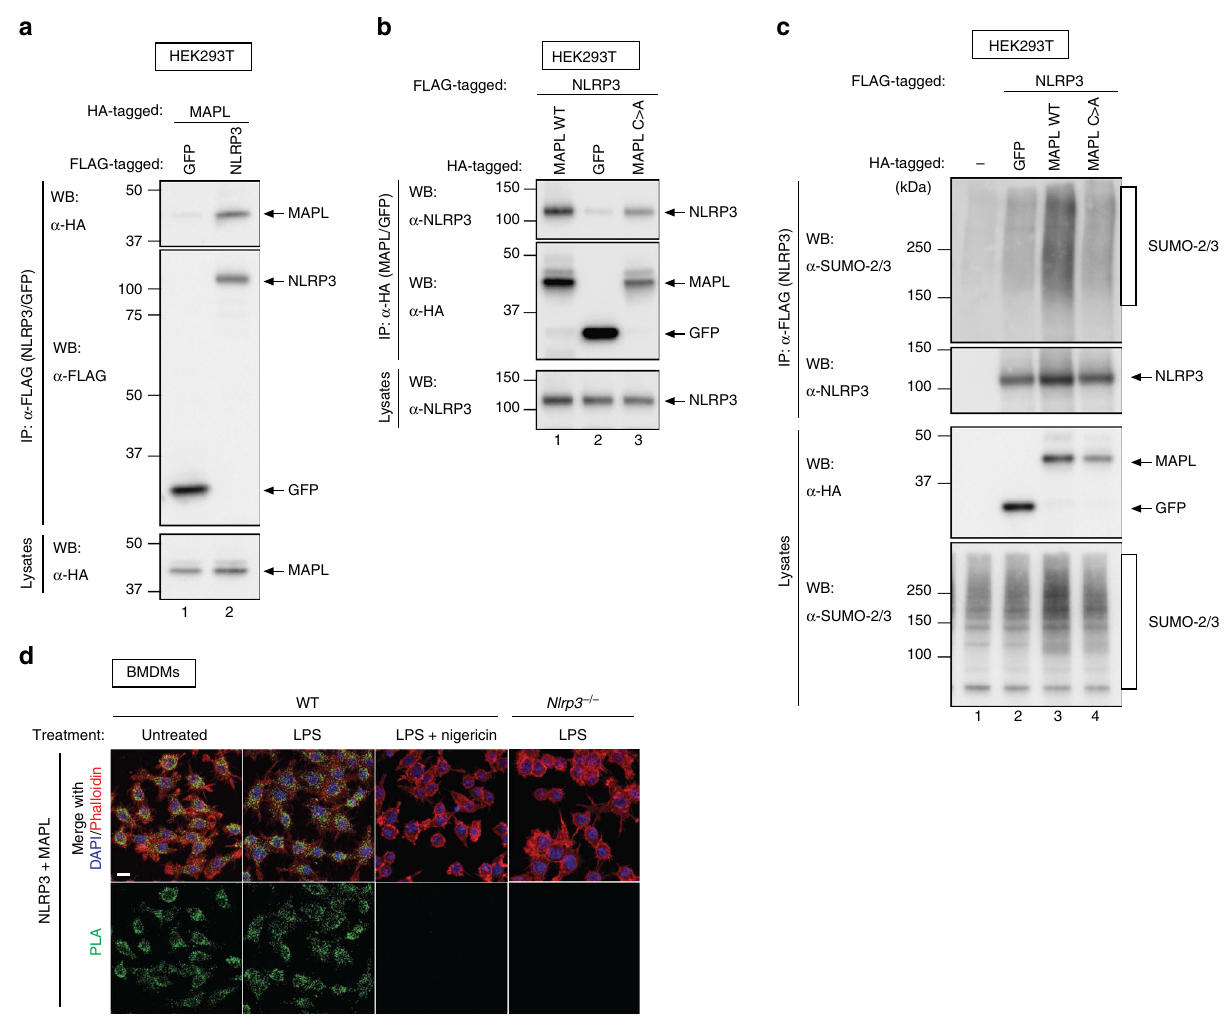
Fig. 3 SUMO E3 ligase MAPL interacts and sumoylates NLRP3. a , b Reciprocal binding study with NLRP3 and MAPL in HEK293T. Expression and co- precipitation was determined by western blot with the indicated antibodies. c Sumoylation of FLAG-NLRP3 in the presence of the indicated proteins. FLAG- NLRP3 was puri fi ed under denaturing conditions and the presence of SUMO modi fi cation on NLRP3 was determined by immunoblot analysis of the eluate. Representative immunoblots of three independent experiments are shown. d The endogenous proximity between NLRP3 and MAPL is lost upon NLRP3 activation. Immortalized BMDMs were left untreated, primed with LPS for 4 h or treated with LPS (4 h) followed by 30 min with nigericin. PLA was performed in biological triplicate using α -NLRP3 and α -MAPL antibodies. Representative confocal microscopy images are shown for each condition.